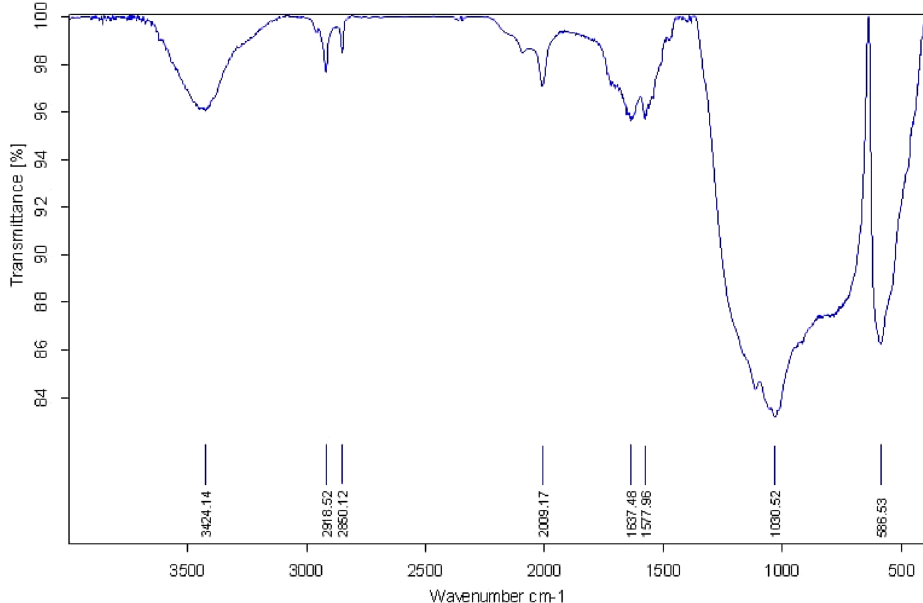
Figure 3. FTIR spectra of RA/Ag NPs prepared using Ranunculus Arvensis